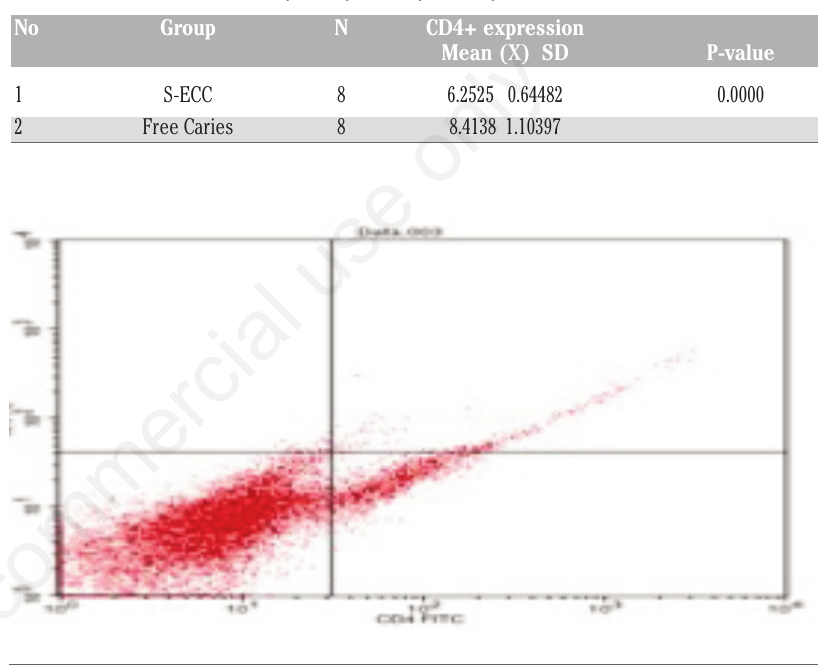
Figure 3. T lymphocytes (CD4 + ) cells Expression (10.24%) in the saliva of Caries Free.